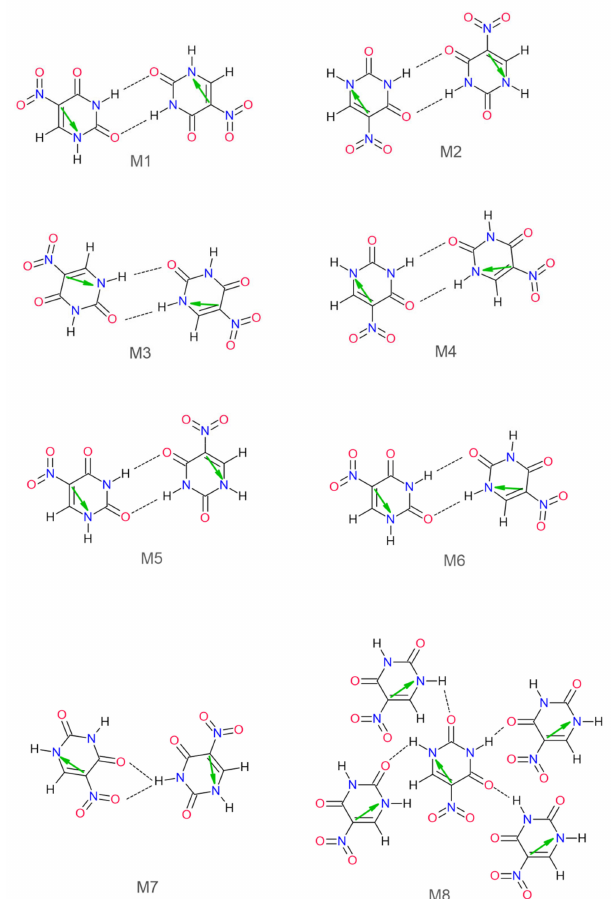
Figure 2. Typical H-bonding schemes with the neutral 5NU, the green arrows represent the dipole moment.